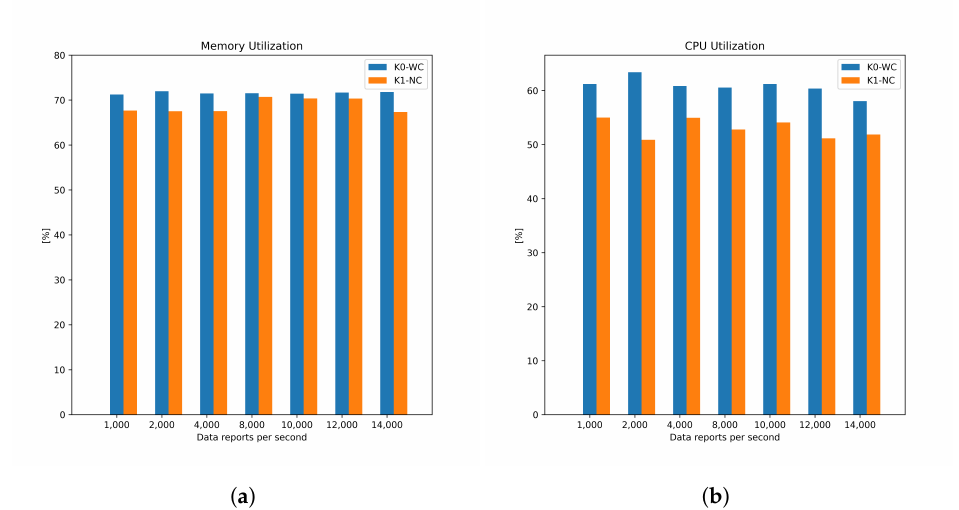
Figure 6. Resource usage for each implementation and Data Reports’ rate. ( a ) Average memory utilization. ( b ) Average CPU utilization.